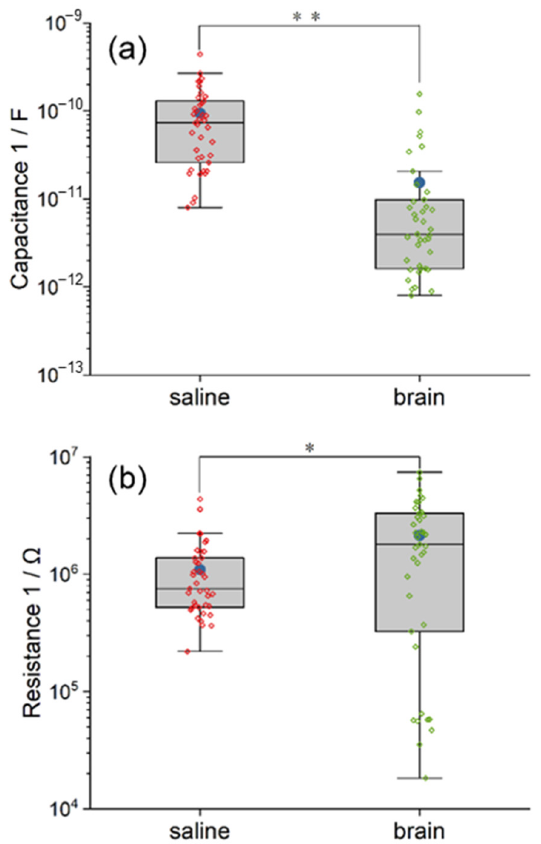
Figure 4. The comparison between the equivalent circuit model of saline and pig brain in the fitted value of C1 ( a ), R1 ( b ). The differences in C1 and R1 between the two models indicate the impact of * p < 0.05; ** p < electrolytes on the double layer capacitance and the diffusion resistance. Significance level was set at * p < 0.05; ** p < 0.01.